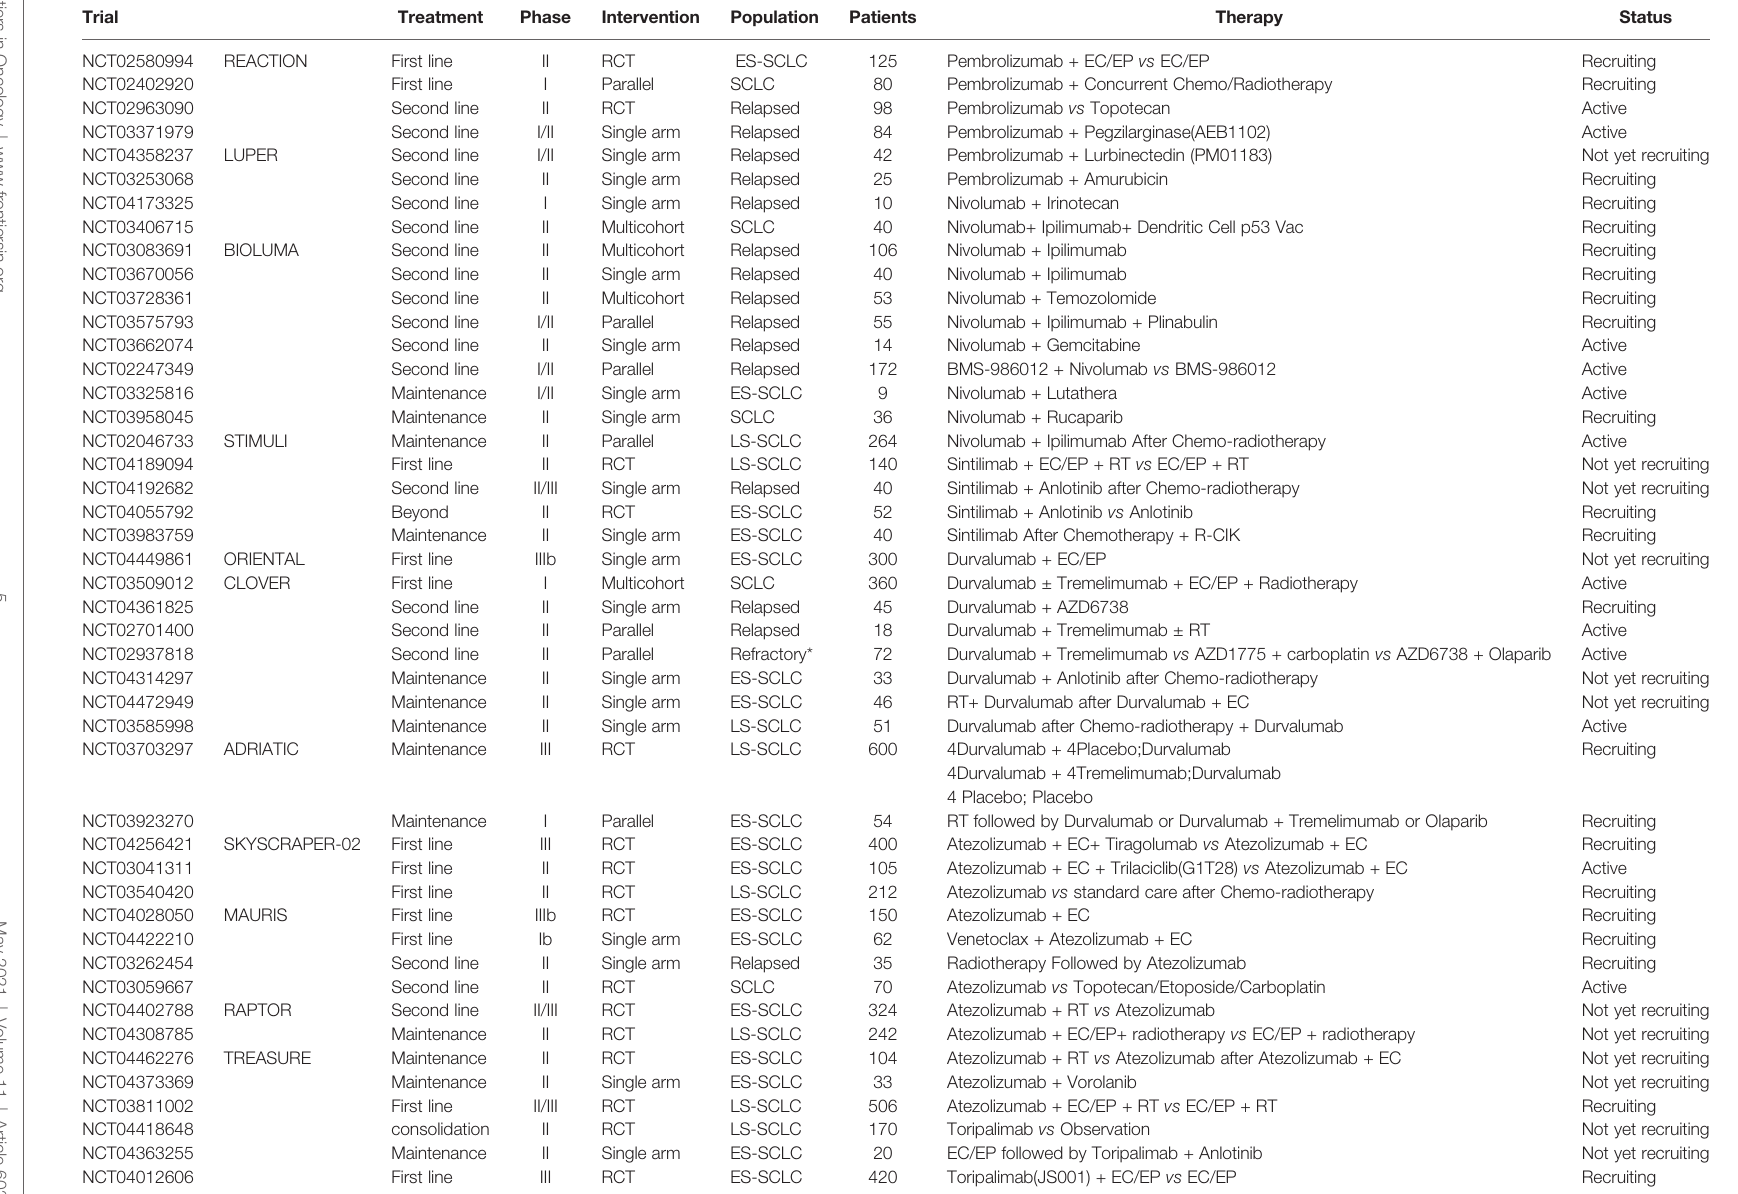
TABLE 1 | Ongoing trial with PD-1/PD-L1 inhibitors in the treatment of small cell lung